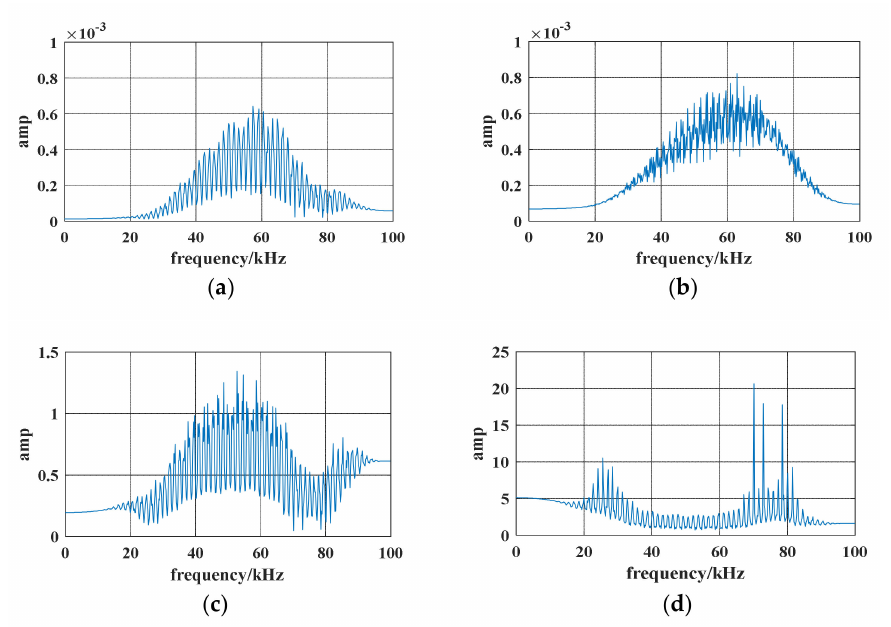
Figure 4. Simulation results of the line-mode current spectrum and frequency-domain current ratio under an external fault: ( a ) current spectrum on the M side; ( b ) current spectrum on the N side; ( c ) frequency-domain current ratio I M / I N ; ( d ) frequency-domain current ratio I N / I M